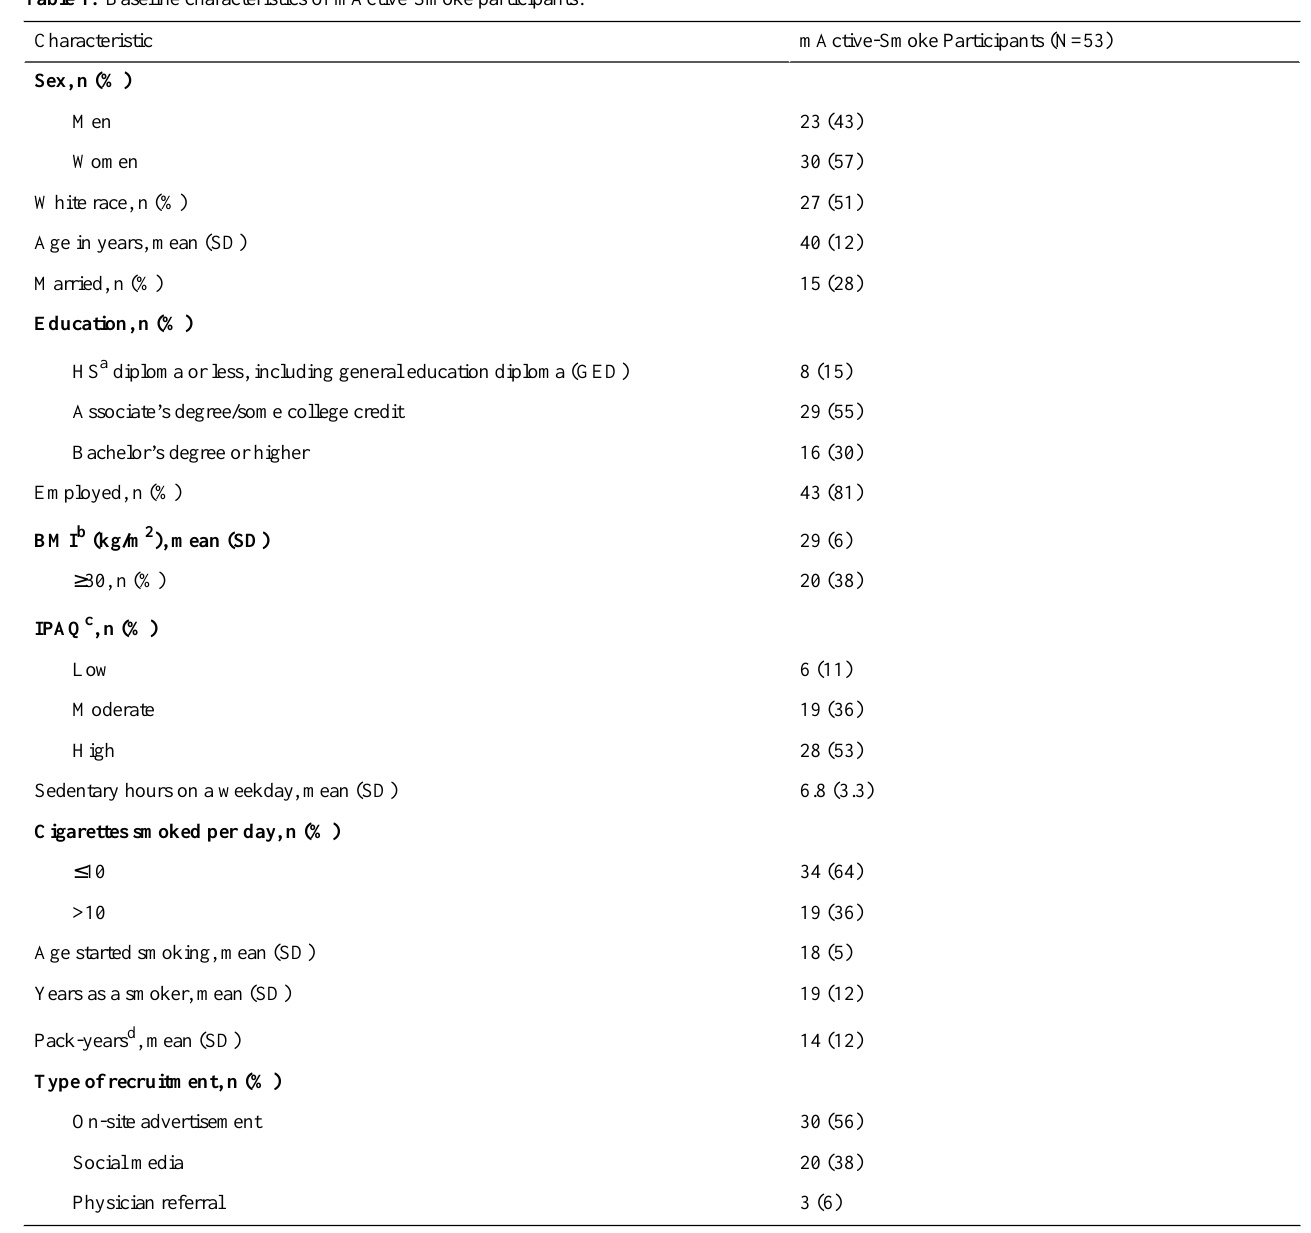
Table 1. Baseline characteristics of mActive-Smoke